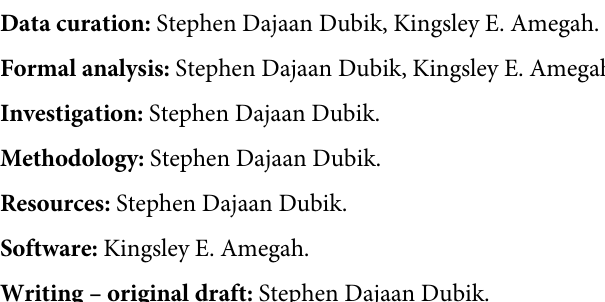
S1 Table. Sociodemographic characteristics, breastfeeding practices and past obstetric his- tory of the study